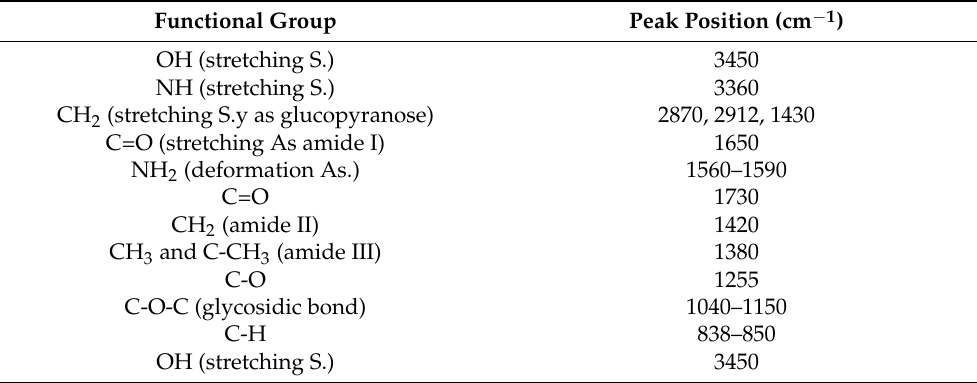
Table 1. Characteristic functional groups of pure CTS.